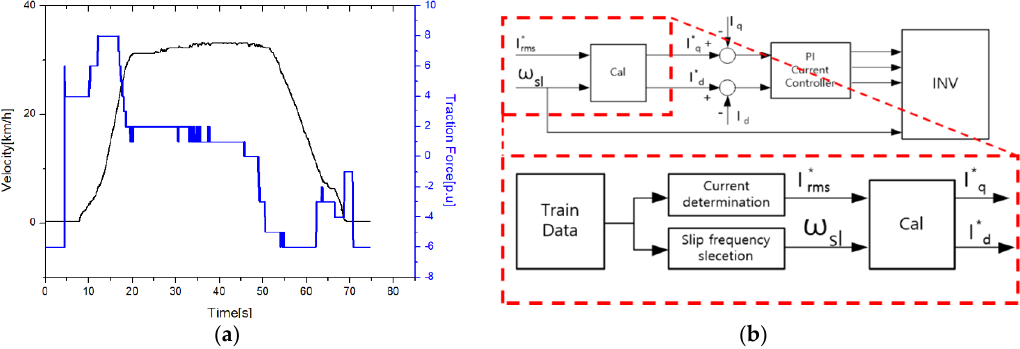
Figure 6. Simulation conditions and calculation blocks: ( a ) Train operation pattern (train data) and ( b ) Block diagram using train pattern